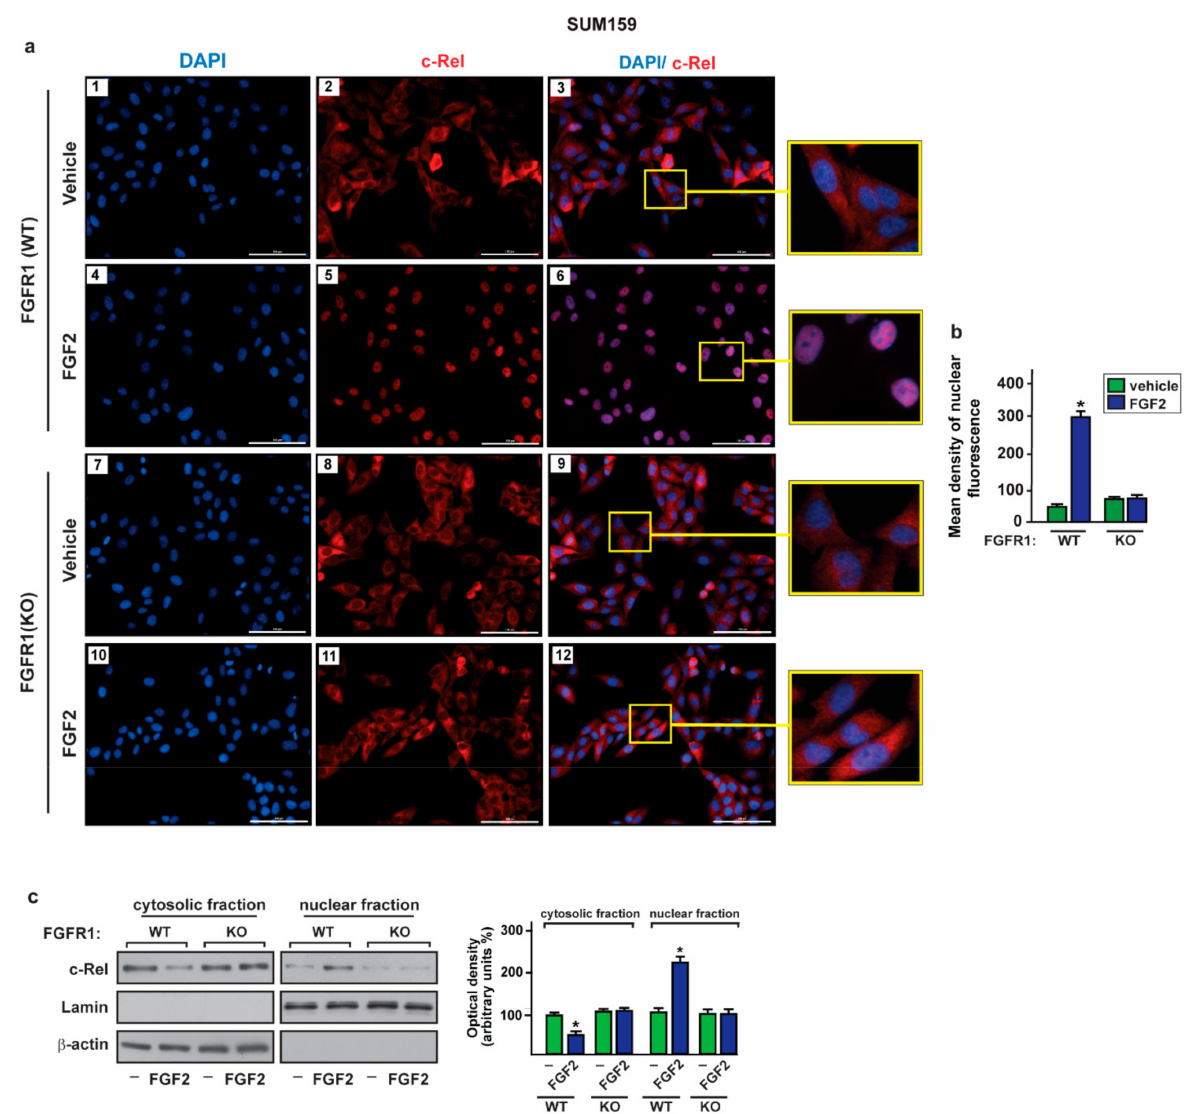
Figure 5. The activation of FGF2/FGFR1 transduction pathway leads to c-Rel nuclear accumulation in SUM159 cells. ( a ) Immunofluorescence staining of c-Rel in FGFR1 (WT) (panels 1–6) and FGFR1 (KO) (panels 7–12) SUM159 cells treated for 2h with vehicle and 25 nM FGF2. c-Rel localization is shown in red, nuclei are stained by DAPI (blue), scale bar = 100 µ m. Enlarged details are shown in the separate box. Images shown are representative of two independent experiments. ( b ) Quantification of nuclear c-Rel in cells treated with vehicle versus cells exposed to FGF2, as indicated. ( c ) Immunoblots of cytosolic and nuclear fraction lysates derived from FGFR1 (WT) and FGFR1 (KO) SUM159 cells treated for 2h with vehicle (-) and 25 nM FGF2, as indicated. β -Actin and lamin were used as cytosolic and nuclear protein markers, respectively. Side panel shows densitometric analysis of the blots normalized to actin (for cytosolic fraction) or to lamin (for nuclear fraction). Values represent the mean ± SD of three independent experiments. (*) indicates p <